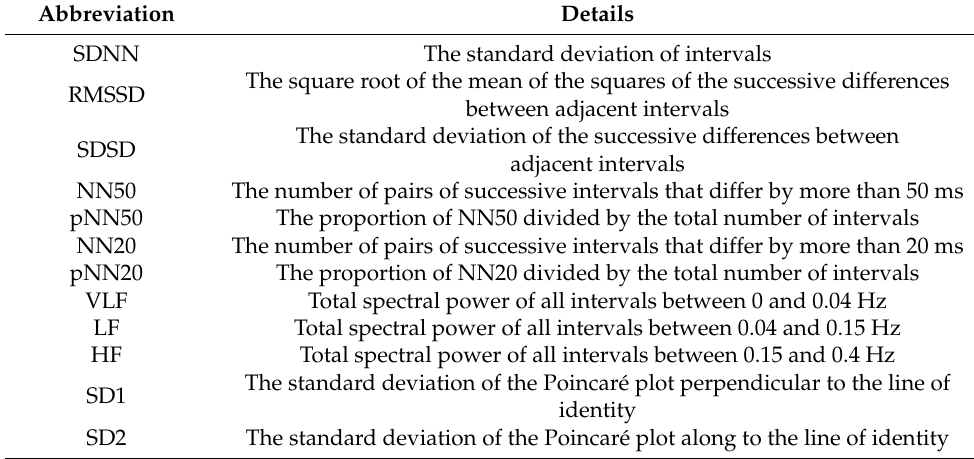
Table 3. Details of morphological features extracted from BVP